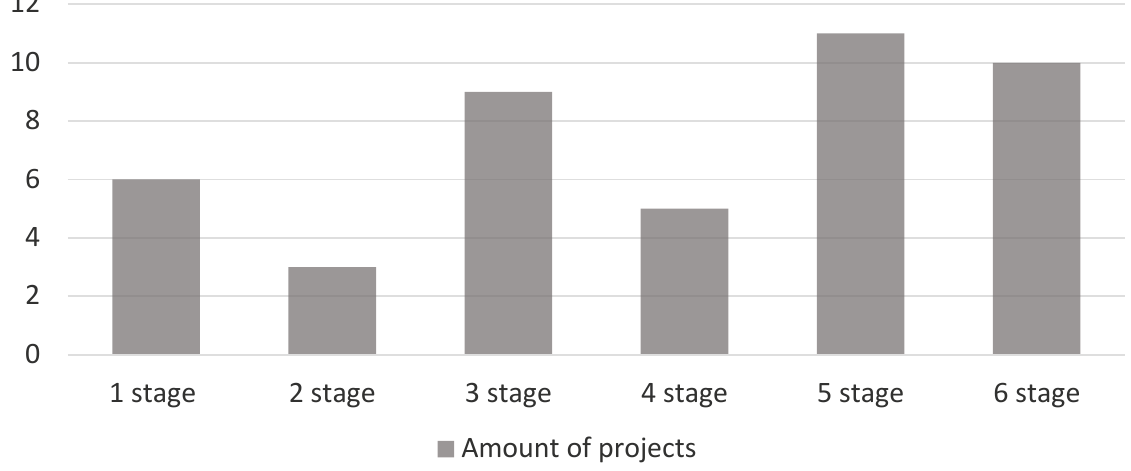
Figure 1. Investment projects by stages of development, pcs.